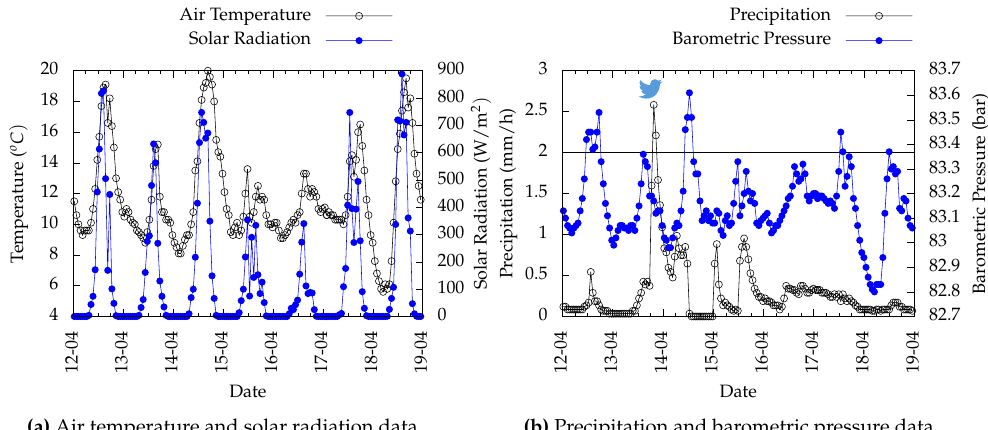
Figure 13. Data from LoRaWAN node with ATMOS41 all-in-one weather station.